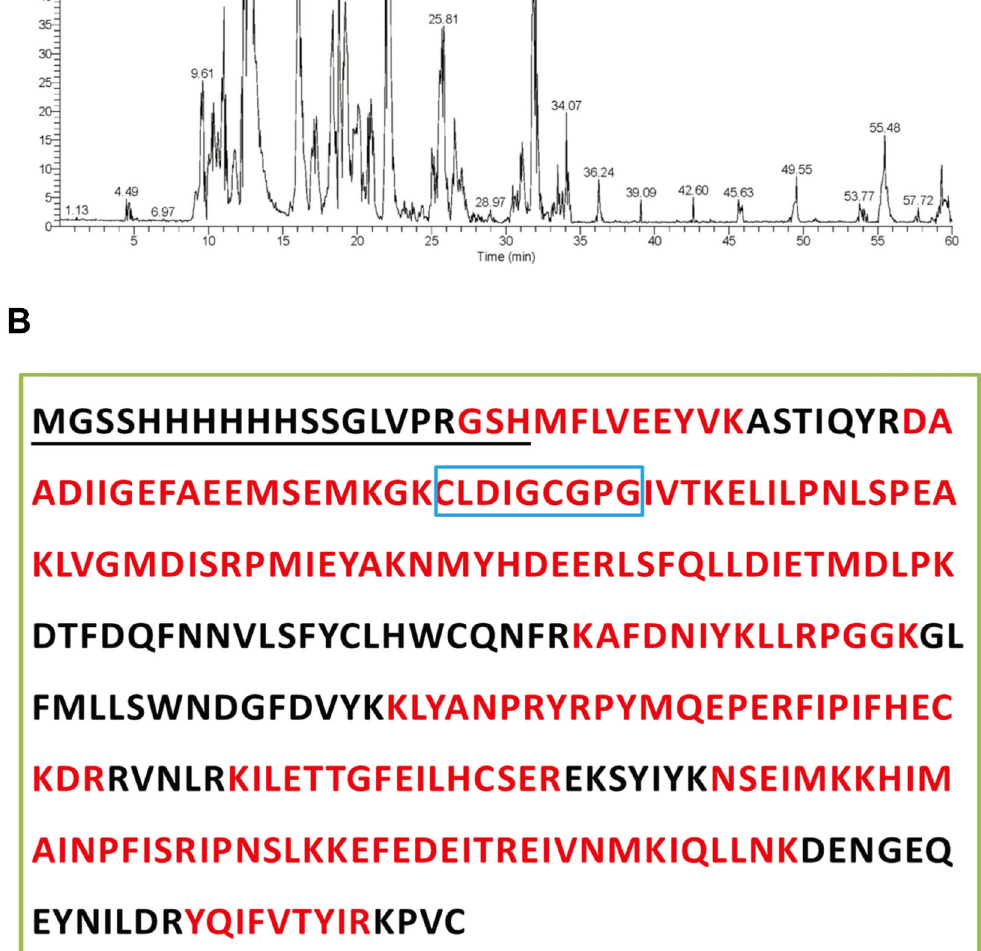
Figure 4. Verification of the AmJHAMT amino acid sequence by LC-MS/MS. (A) Total ion chromatograms (TIC). Numbers on the top of peaks indicate the retention time of a single peptide. (B) Sequence coverage of recombinant AmJHAMT by identified peptides. The red characters indicate amino acid residues covered by LC-MS/MS peptides. Characters underlined show the additional sequence from expression vector. Characters marked with blue box indicate the motif I.